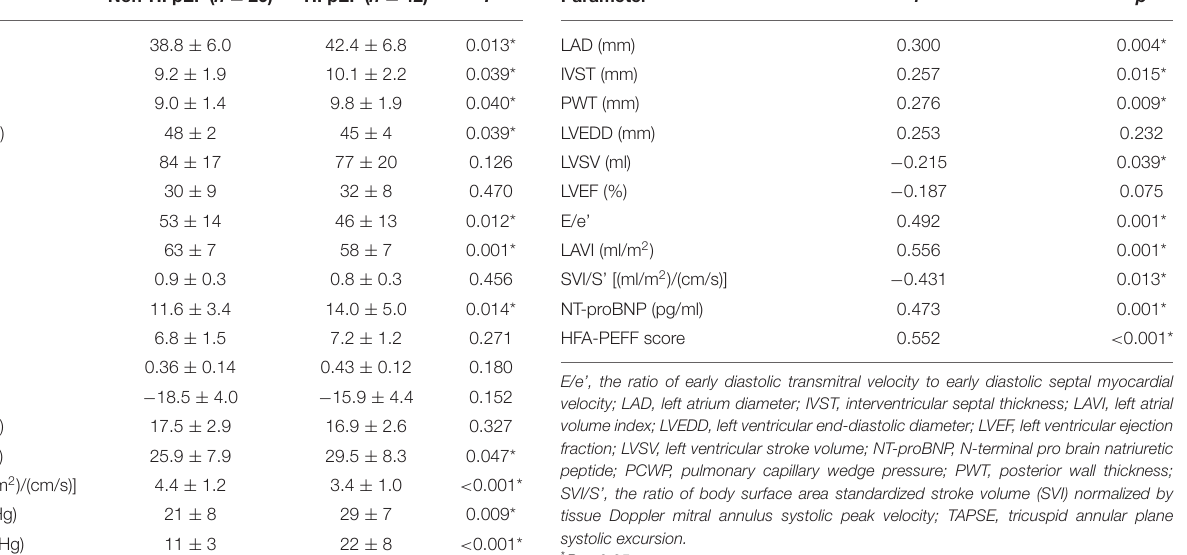
TABLE 3 | Echocardiographic and invasive parameters of patients. Parameter